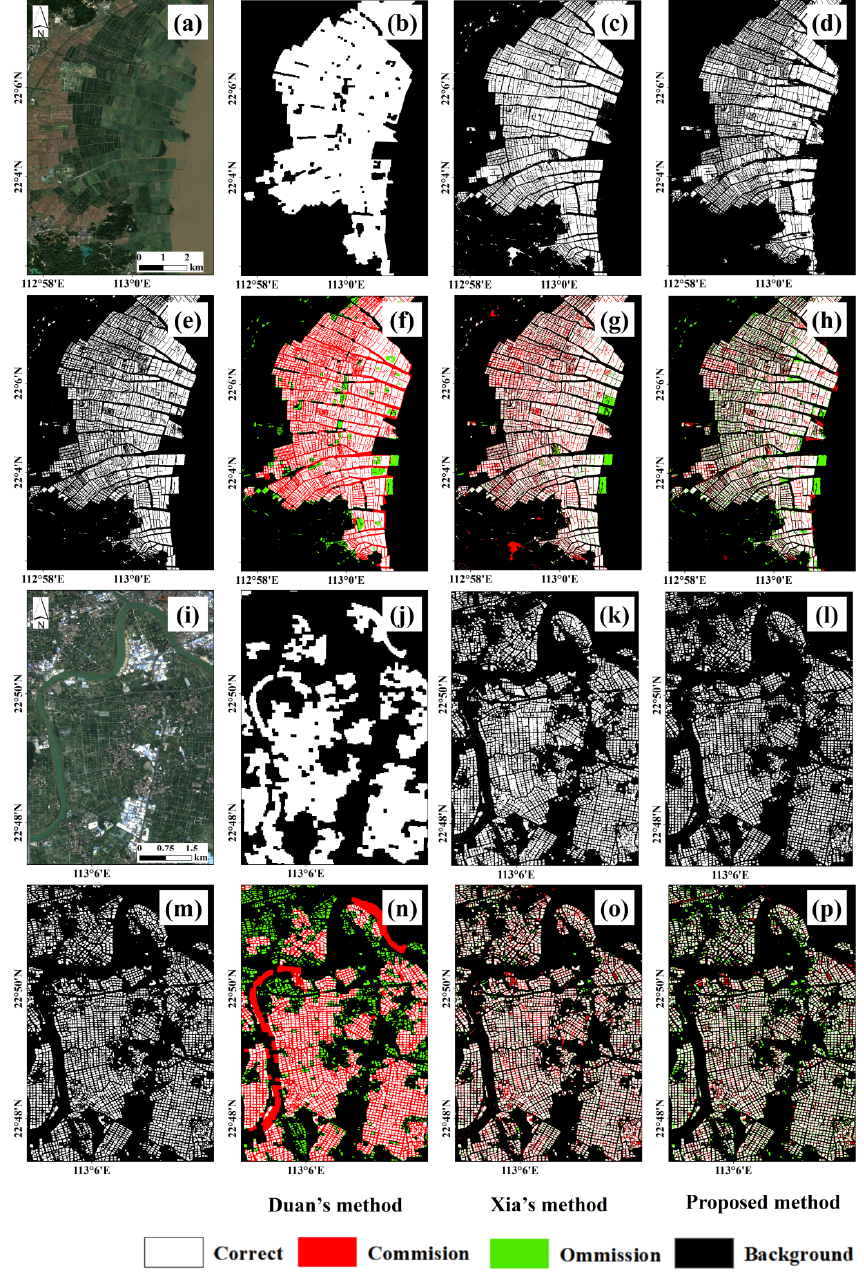
Figure 12. Aquaculture maps obtained using three methods. ( a , i ) present the Sentinel-2A true color images, and their corresponding reference maps are presented in ( e ,m). The results obtained using Duan’s [ 42 ] , Xia’s [ 39 ], and the proposed approach are presented in ( b – d ) and ( j – l ), respectively. Their comparisons with the ground truth maps are presented in ( f – h ) and ( n – p ), respectively.